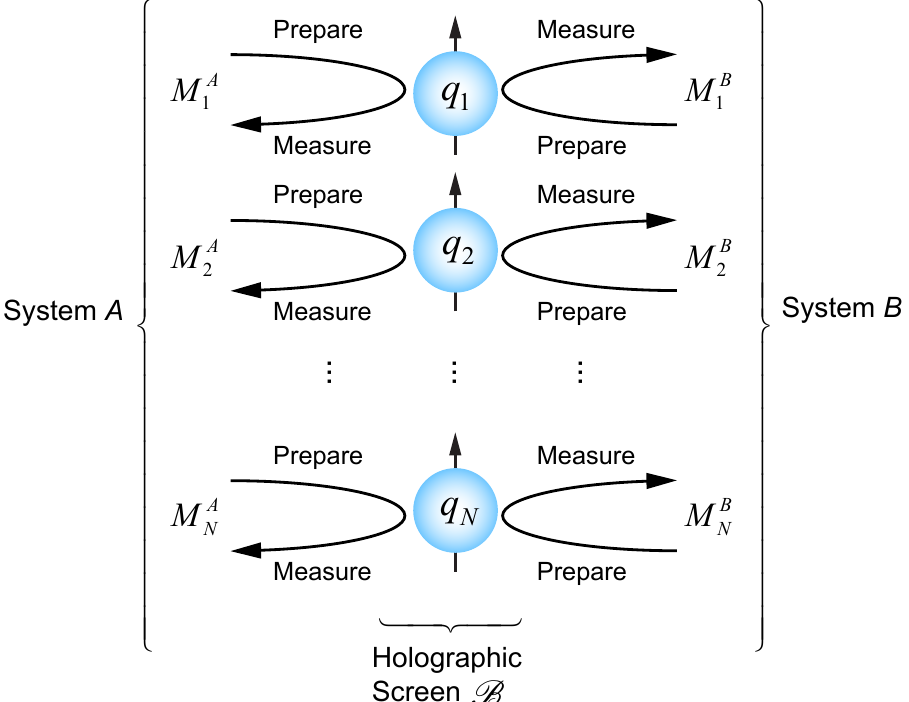
Figure 1: A holographic screen B separating finite systems A and B with an interaction H AB given by Eq. (3) can be realized by an ancillary array of noninteracting qubits that are alternately prepared by A (B) and then measured by B (A). Qubits are depicted as Bloch spheres [25]. There is no requirement that A and B share preparation and measurement bases, i.e. quantum reference frames (QRFs). Adapted from